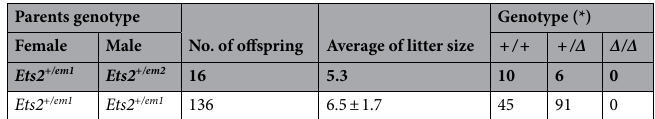
Table 1. Lethality of Ets2 mutant. (*) em1 or em2 allele shown as